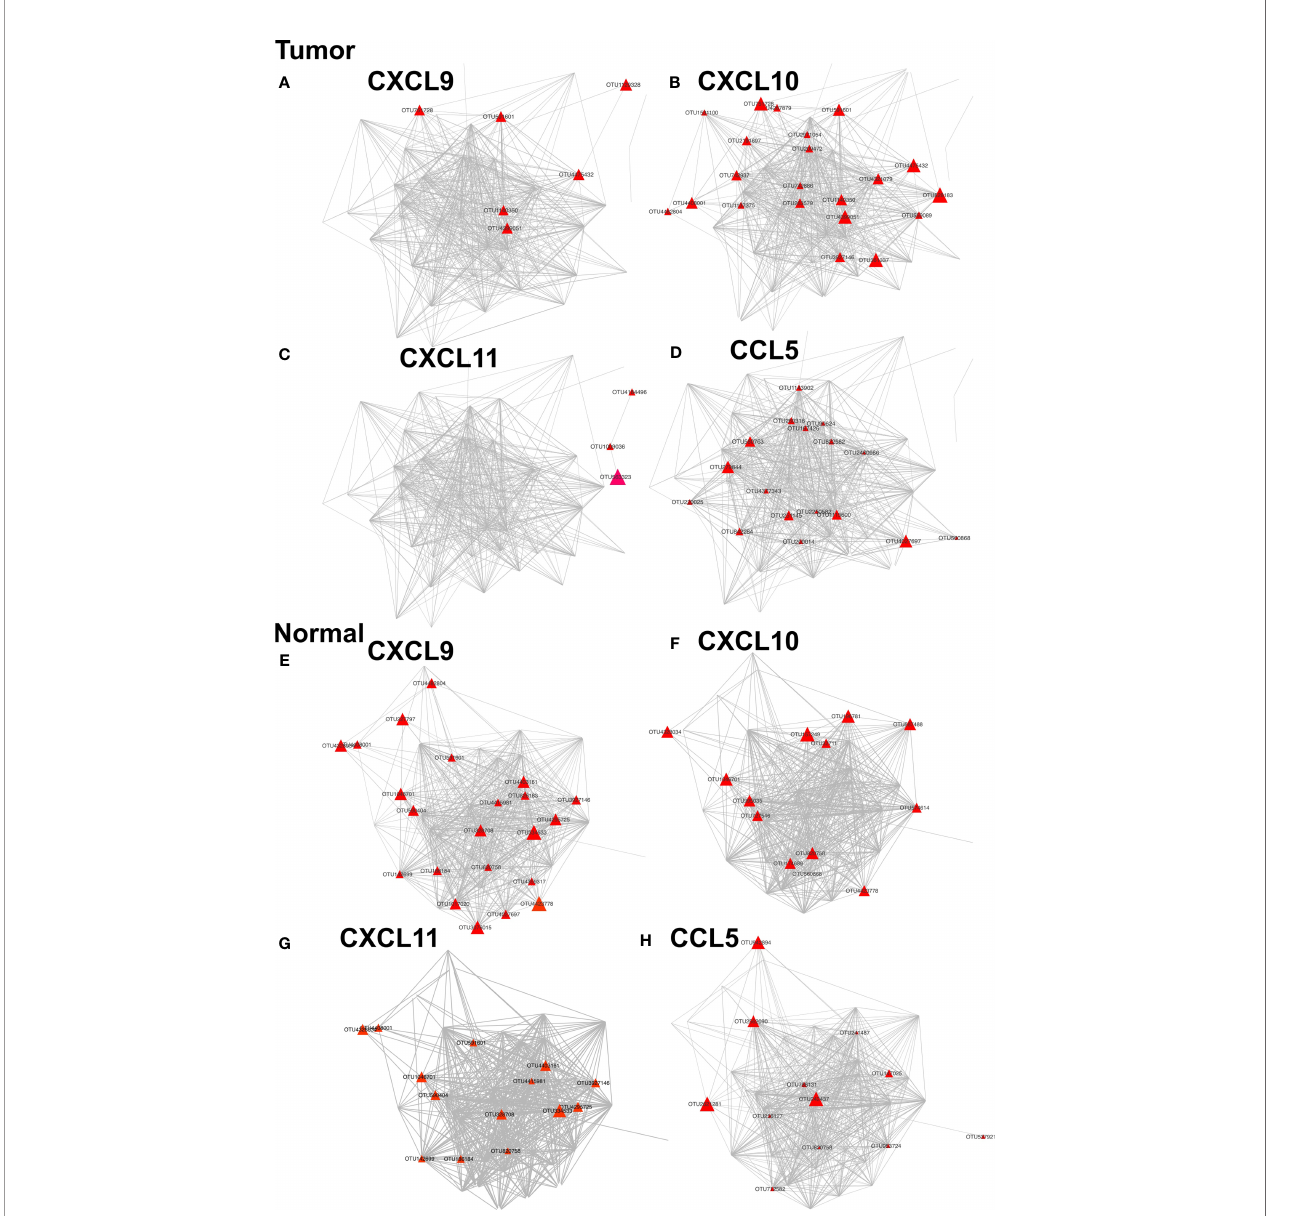
FIGURE 7 | Networks of OTUs associated with CTTCs in tumor and adjacent normal tissues. Each node represents an OTU. Nodes (OTUs) are shown if the abundance of the OTU is signi fi cantly correlated with the expression of CXCL9 , CXCL10 , CXCL11 , or CCL5 in either tumors (A – D) or adjacent normal mucosae (E – H) ( p < 0.05). The color and size of nodes denote the P value and correlation coef fi cients ( r ) of correlation between OTUs and